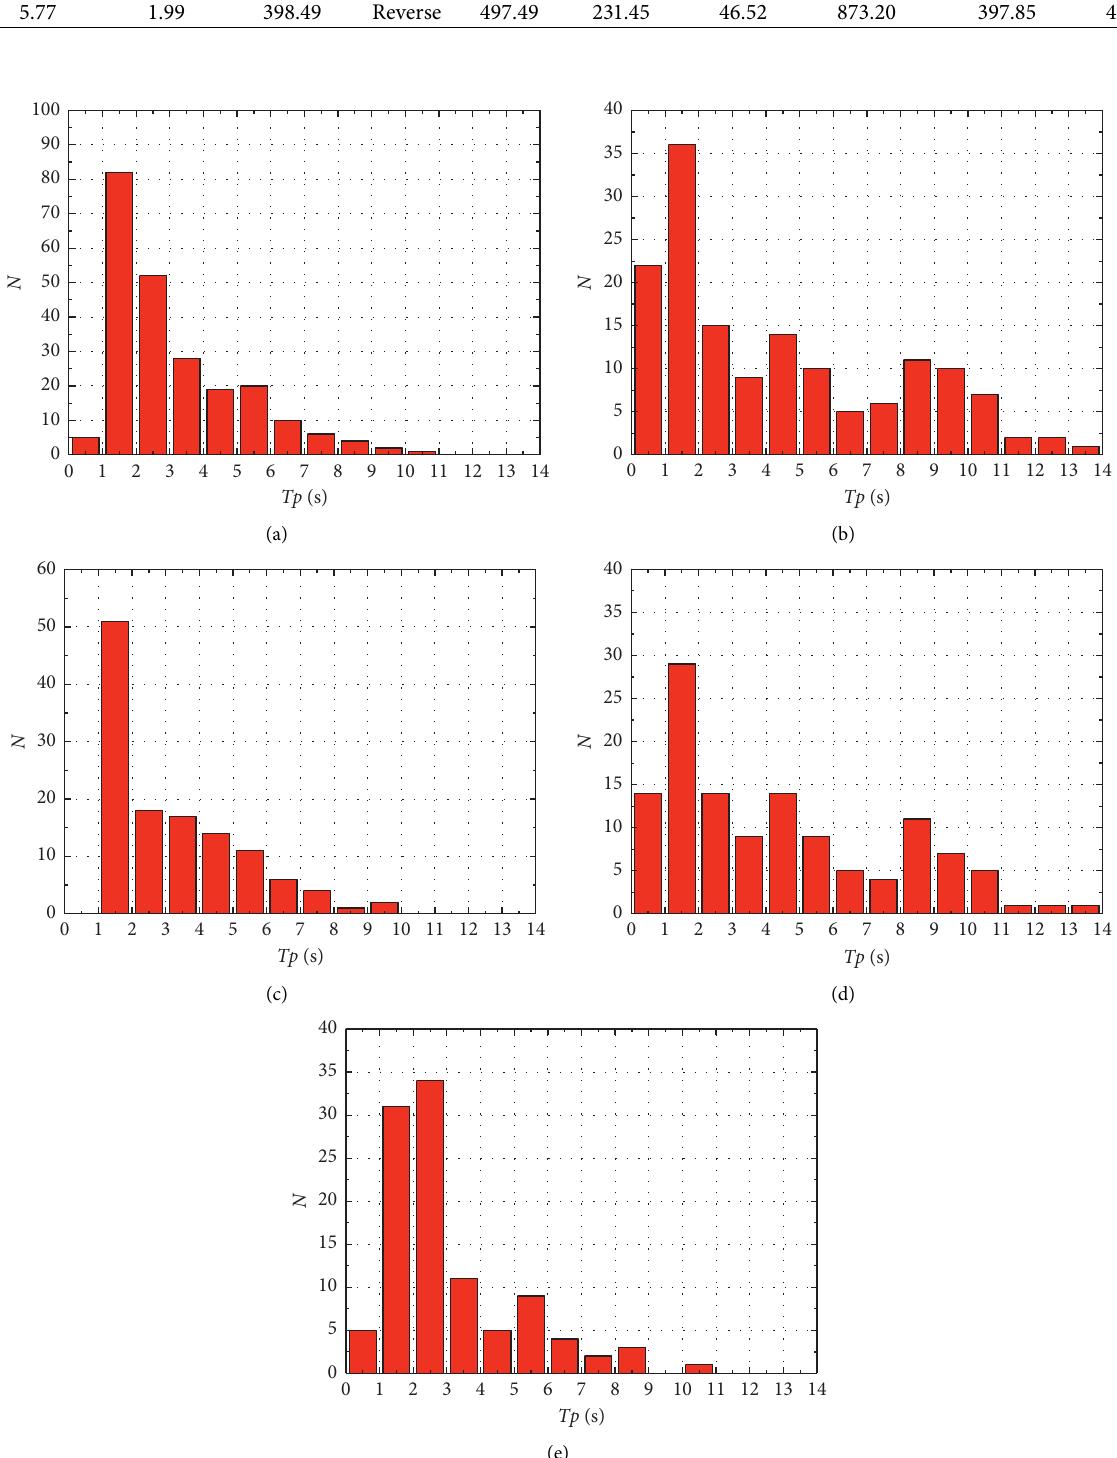
Figure 21: Distribution of velocity pulse period. (a) HHT1. (b) Wavelet1. (c) HHT2. (d) Wavelet2. (e)